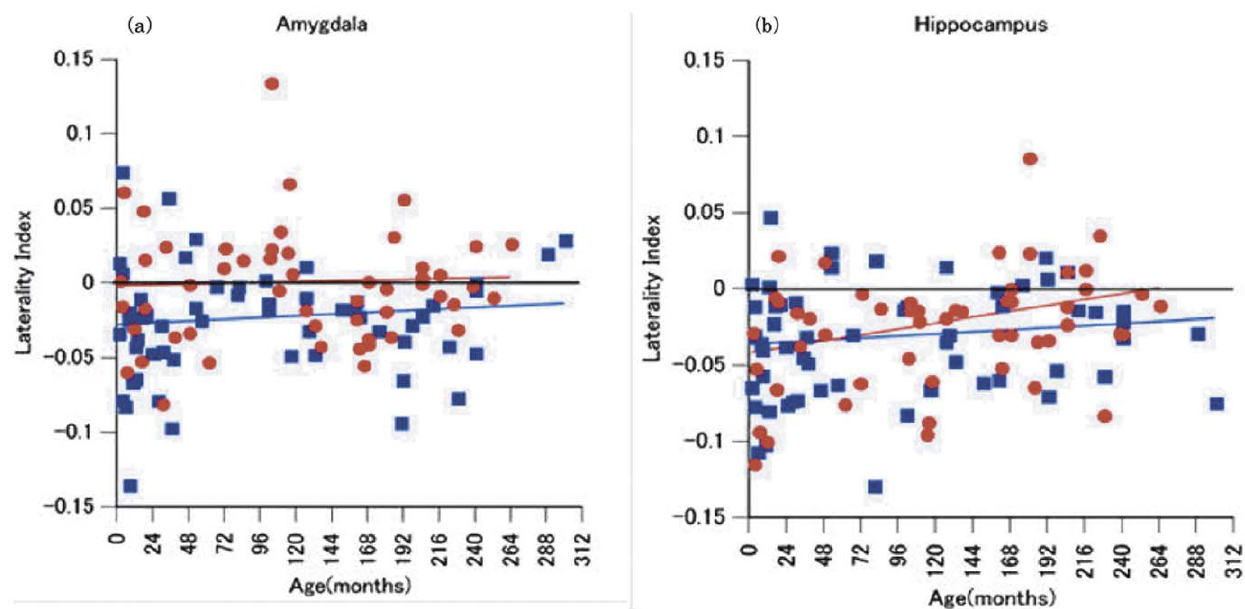
Figure 6. The relationship between laterality index and age. (a) amygdala, (b) hippocampus. Blue square and blue line: male. Red circle and red line: